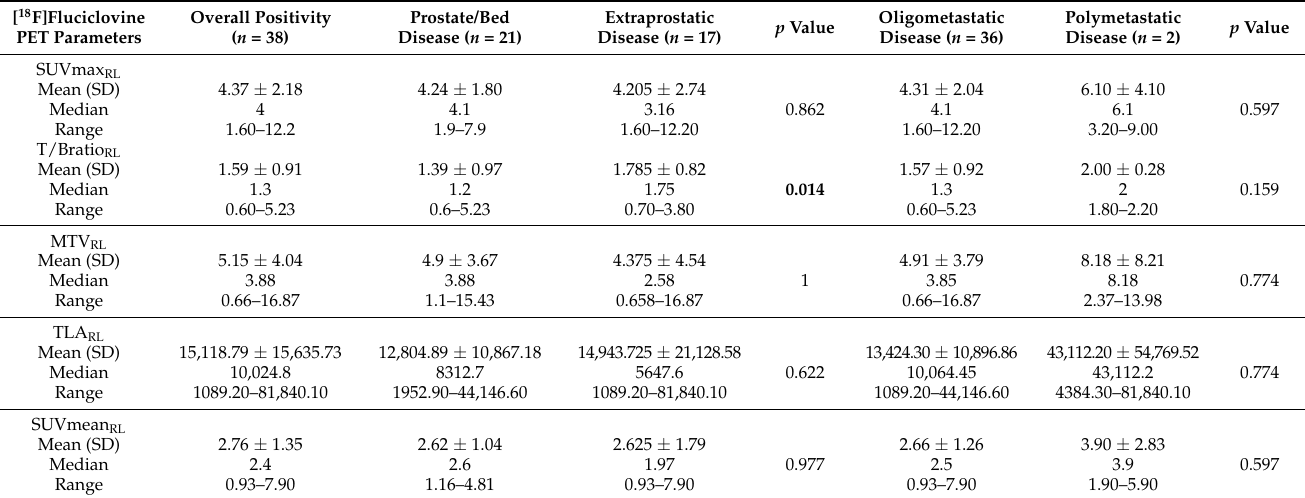
Table 5. Correlation between semiquantitative parameters and subpopulation analysis.